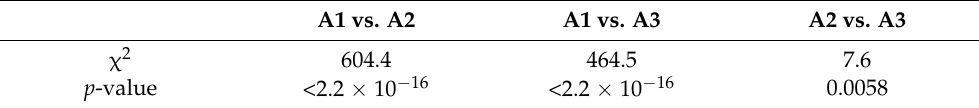
Table 6. McNemar test between the three approaches’ performances against weather stations.